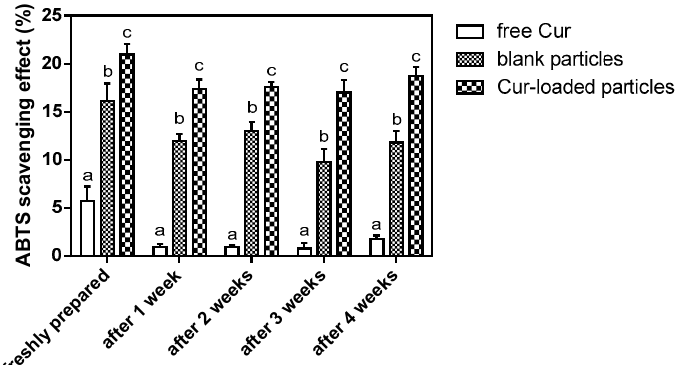
Figure 7. ABTS • + radical scavenging capacity of the model beverage incorporated with free Cur, blank zein ‐ caseinate ‐ pectin particles or Cur ‐ loaded zein ‐ caseinate ‐ pectin particles during storage at 4 °C. Values marked with different letters indicated a significant difference between different groups for the same storage time period ( p < 0.05). Error bars represent standard deviations from three replicates.